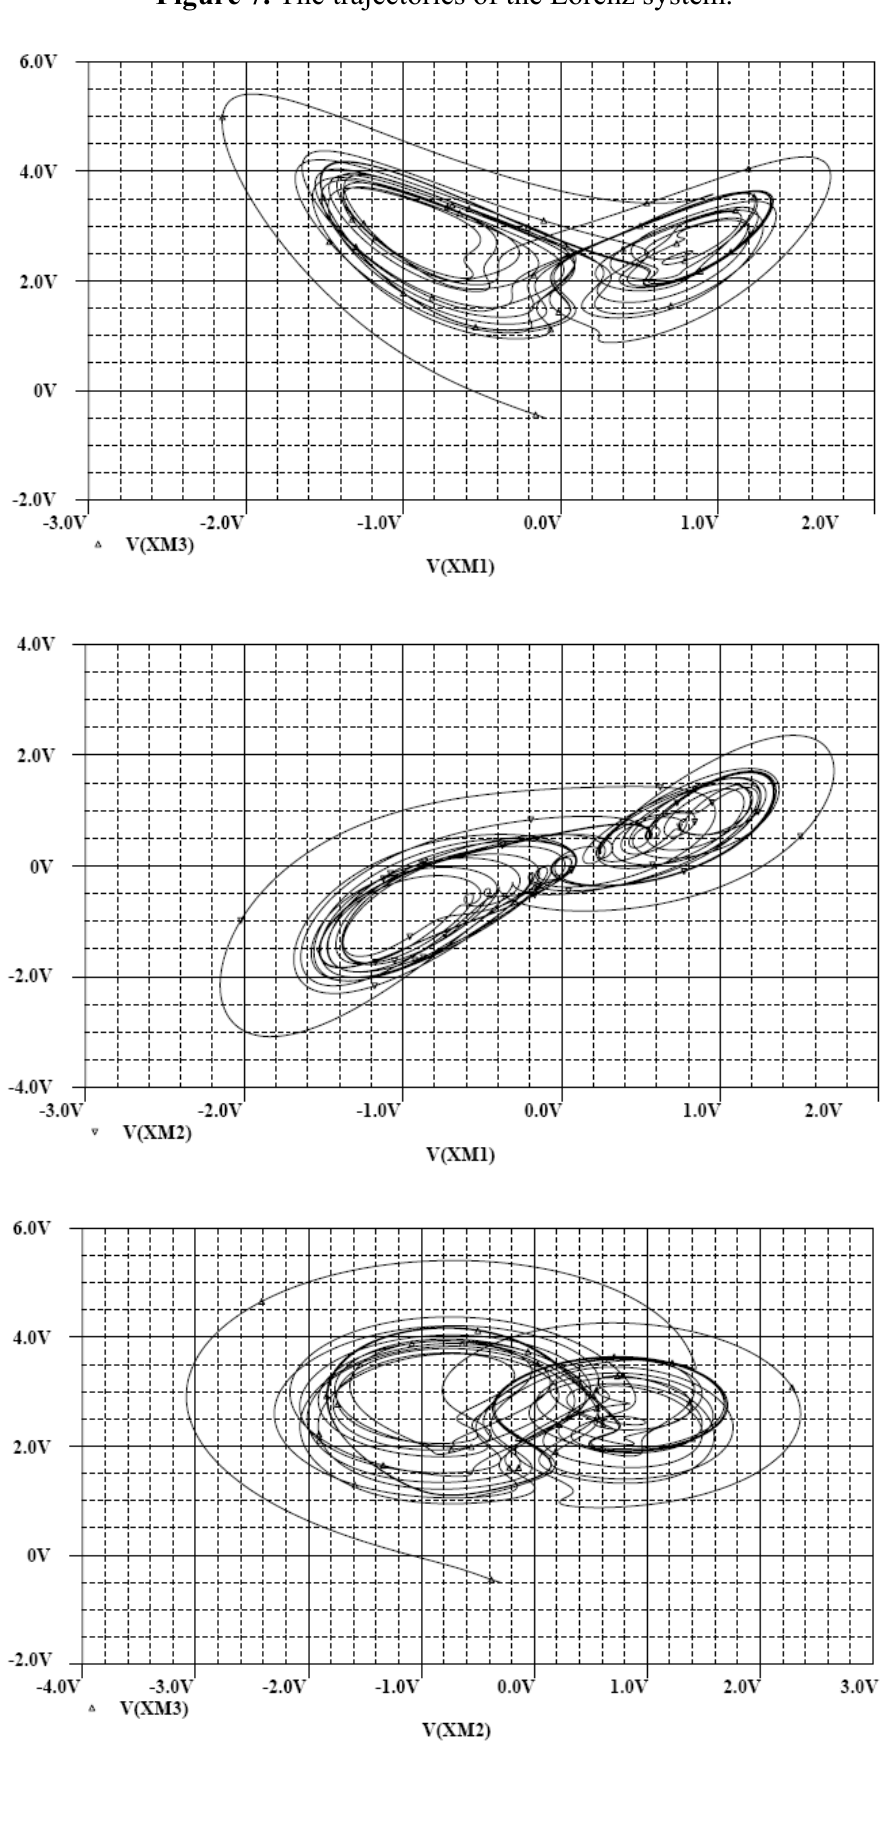
Figure 7. The trajectories of the Lorenz